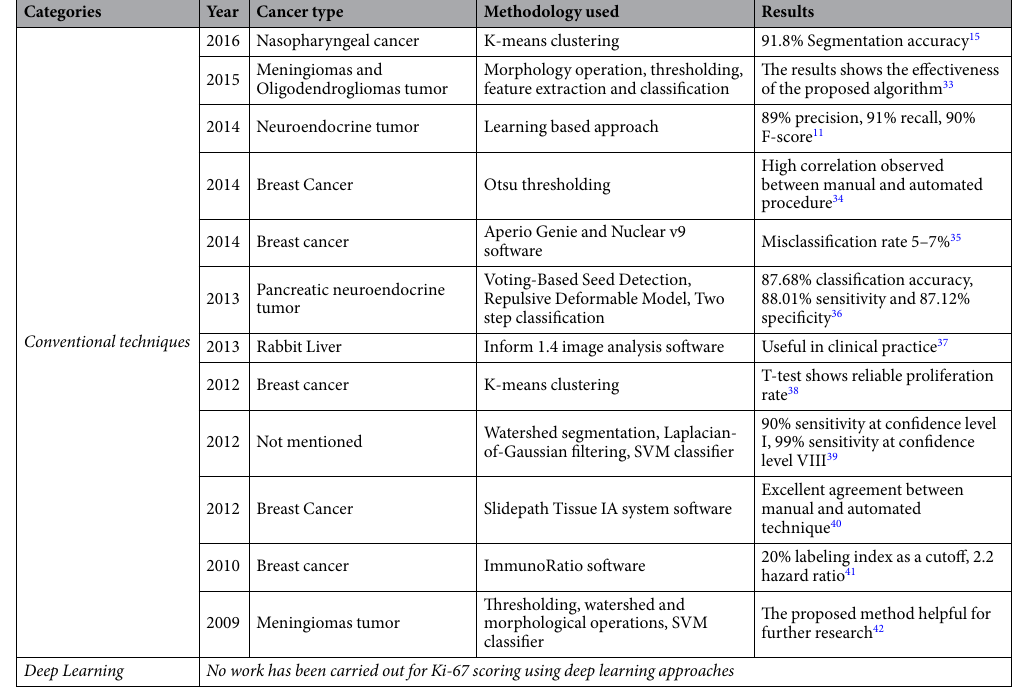
Table 1. Characterization of Ki-67 scoring